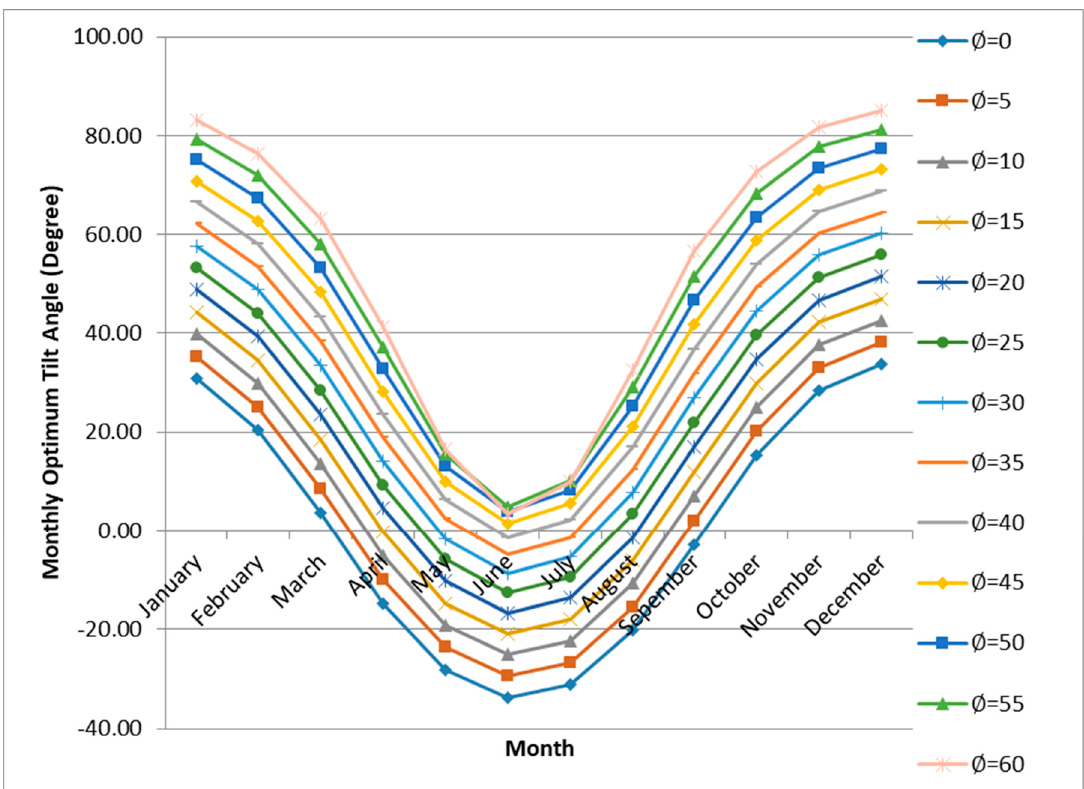
Figure 5. The monthly optimum tilt angle β opt,m for different latitudes.